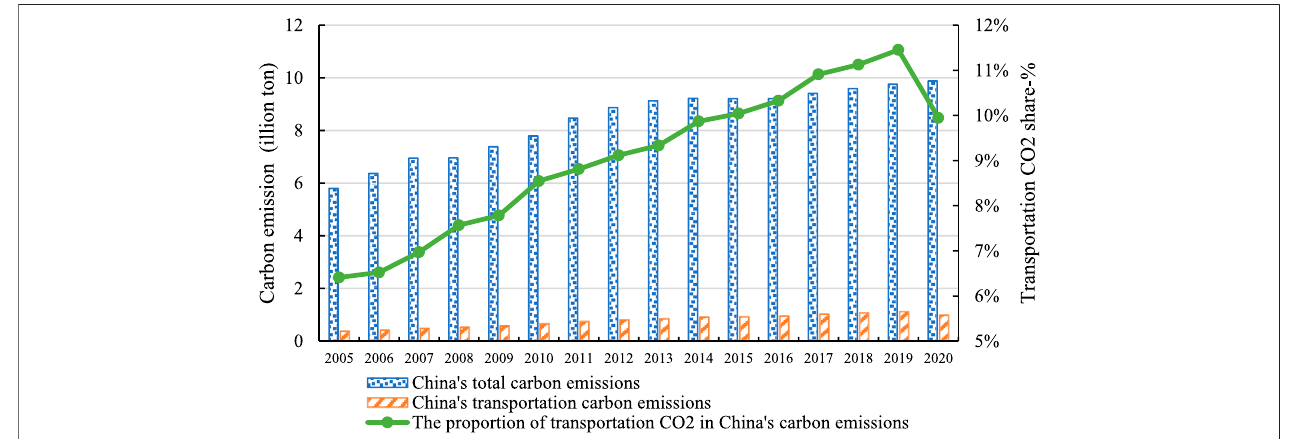
FIGURE 1 | China ’ s transportation carbon